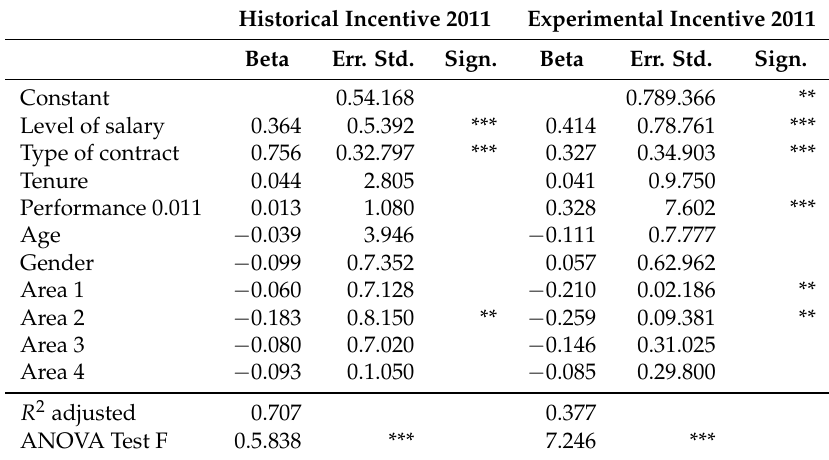
Table 9. Results of linear regressions described in Equations (4) and (5). ** Significant at the 5%. *** Significant at the